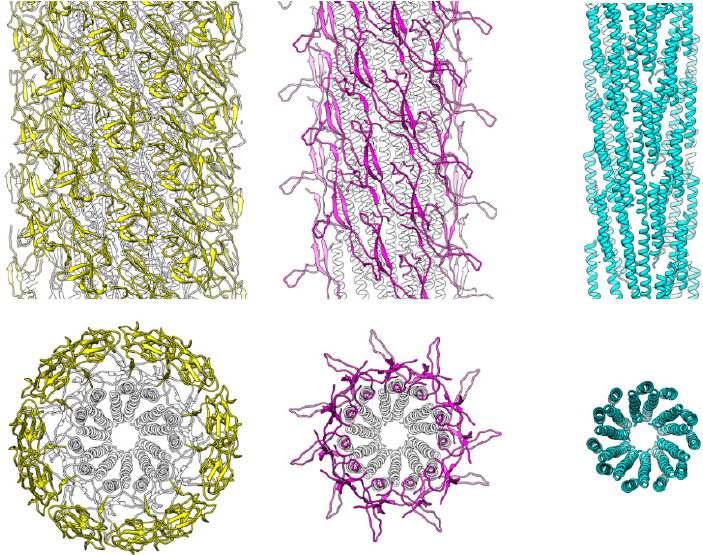
Figure 6. Structures and spatial arrangements of FlgG domains in the rod. The C α ribbon models are presented in side and end-on views in the upper and lower panels, respectively, to visualize the structure and helical array of each of the three domains in different colors: D1, yellow; Dc, magenta; and D0, light blue, from left to right. The structure of FlgG is very similar to that of FlgE except for the length of the β -hairpin of domain Dc, with the extra length formed by the FlgG-specific 18 residue insertion projecting out nearly horizontally in the